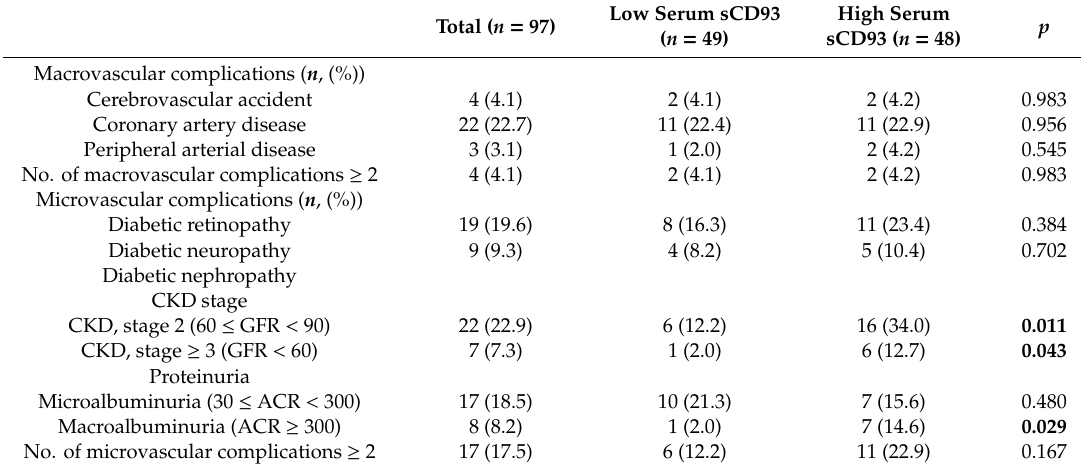
Table 2. Prevalence of macro- and microvascular diabetic complications according to serum sCD93